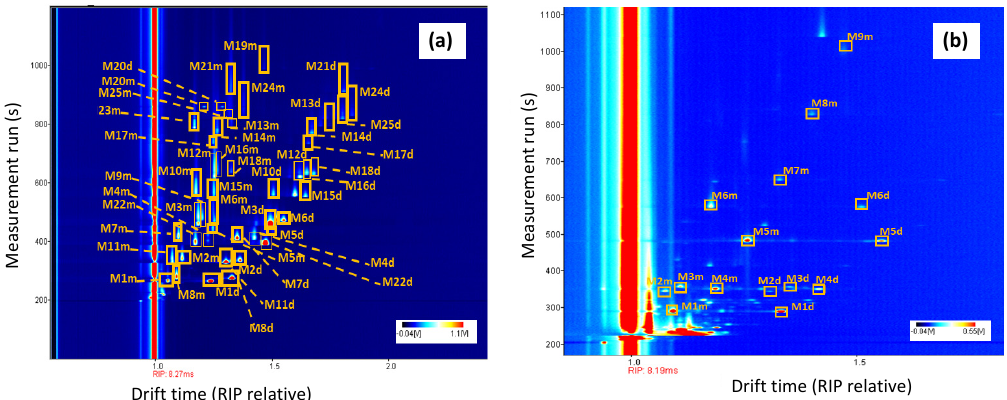
Figure 2. Topographic maps of the standards mixture ( a ) and an EVOO sample ( b ) showing the volatile compounds identified by HS-GC coupled with ion mobility spectrometry (IMS): (M1m) 2-butanone monomer, (M1d) 2-butanone dimer, (M2m) 2-pentanone monomer, (M2d) 2-pentanone dimer, (M3m) 2-hexanone monomer, (M3d) 2-hexanone dimer, (M4m) 2-methyl-1-butanol monomer, (M4d) 2-methyl-1-butanol dimer, (M5m) 1-pentanol monomer, (M5d) 1-pentanol dimer, (M6m) hexanal monomer, (M6d) hexanal dimer, (M7m) trans-2-pentenal monomer, (M7d) trans-2-pentenal dimer, (M8m) ethyl acetate monomer, (M8d) ethyl acetate dimer, (M9m) ethyl butyrate monomer, (M10m) trans-2-hexen-1-al monomer, (M10d) trans-2-hexen-1-al dimer, (M11m) 1-penten-3-one monomer, M11d) 1-penten-3-one dimer, (M12m) 2-heptanone monomer, (M12d) 2-heptanone dimer, (M13m) 2-octanone monomer, (M13d) 2-octanone dimer, (M14m) 1-octen-3-one monomer, (M14d) 1-octen-3-one dimer, (M15m) ethyl isovalerate monomer, (M15d) ethyl isovalerate dimer, (M16m) propyl butyrate monomer, (M16d) propyl butyrate dimer, (M17m) trans-2-heptenal monomer, (M17d) trans-2-heptenal dimer, (M18m) heptanal monomer, (M18d) heptanal dimer, (M19m) nonanal monomer, (M20m) limonene monomer, (M20d) limonene dimer, (M21m) trans-2-octenal monomer, (M21d) trans-2-octenal dimer, (M22m) 4-methyl-pentan-2-one monomer, (M22d) 4-methyl-pentan-2-one dimer, (M23m) 6-methyl-5-hepten-2-one monomer, (M24m) hexyl acetate monomer, (M24d) hexyl acetate dimer, (M25m) 3-hexenyl acetate, (M25d) 3-hexenyl acetate.